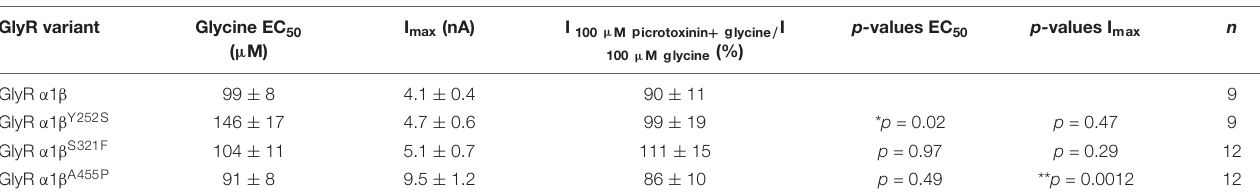
FIGURE 3 | Glycine receptor β subunit mutants alter functional properties of the chloride channel. Electrophysiological measurements of transfected HEK-293 cells. GlyR α 1 alone (green bar), co-transfection of α 1 and β WT (red bar) or β variants (Y252S, S321F, and A455P; black bars). (A) Block of the glycine-gated response using 100 µ M glycine and 100 µ M of picrotoxinin. Bars show residual currents after picrotoxinin block normalized to currents evoked by 100 µ M glycine application. Dotted line shows cut-off for determination of heteromeric receptor configuration. Only cells above the cut-off were used for analysis. (B,C) I max and EC 50 mean values are depicted. (D–F) Dose-response curves for α 1 β (red line) or α 1 β x variants [Y252S (D) , S321F (E) , and A455P (F) ; black lines] using increasing glycine concentrations (10, 30, 60, 100, 300, 600, and 1,000 µ M). Values were normalized to the I max mean value of the according α 1 β variant following application of 1,000 µ M glycine. (G–I) Dose-response curves of α 1 β (red line) or α 1 β x variants [ (G) Y252S, (H) S321F, and (I) A455P black lines] normalized to WT α 1 β I max mean value following application of 1,000 µ M glycine. Representative traces at 1,000 µ M glycine application of α 1 β (red traces) and α 1 β x variants are depicted in the upper left corner of each diagram. Significance values are * p < 0.05, ** p < 0.01, and *** p < 0.001. TABLE 2 | Electrophysiological properties of GlyR α 1 β and α 1 β x